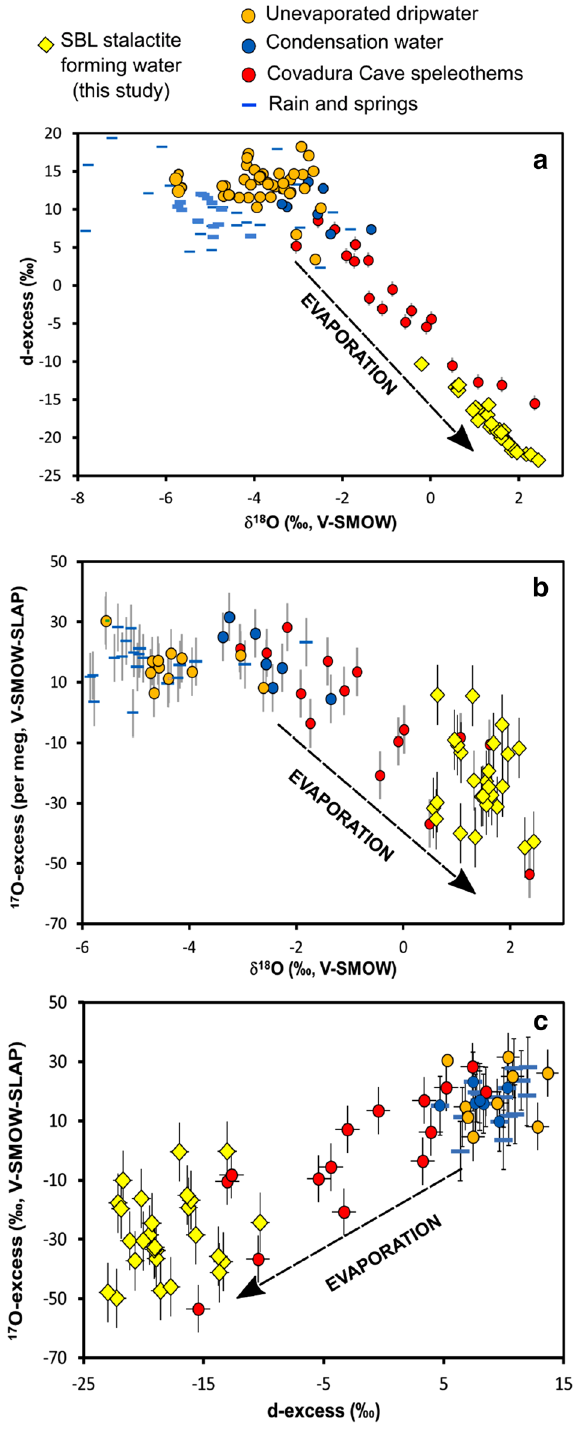
Figure 4. Cross-plots of stable isotopes in gypsum speleothem-forming water (obtained from GHW after applying fractionation factors; see main text) in Sima Blanca Cave, compared to gypsum speleothem-forming water in Covadura Cave (2 km apart from Sima Blanca), unevaporated cave water (dripwater and condensation water) and rainwater in the gypsum karst of Sorbas 5